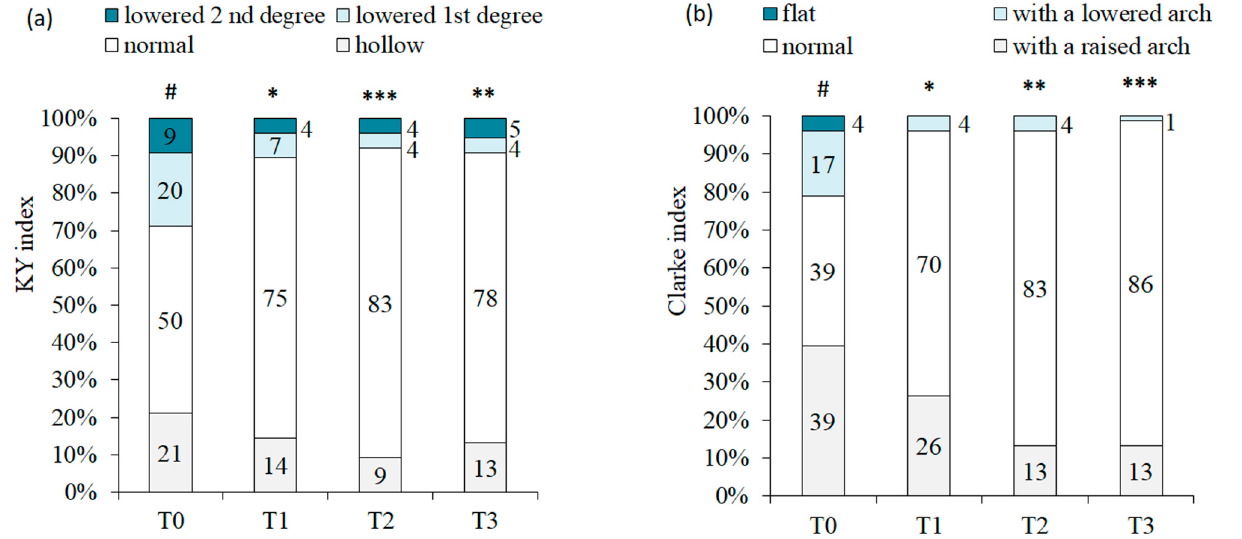
Figure 3. Percentage of feet with different longitudinal arches determined by Sztriter–Godunow index (KY) ( a ) and Clarke index (CL) ( b ) in group T before the treatments (T0), # p before_after < 0.001; and after 1 (T1), 2 (T2), and 3 (T3) treatments; * p < 0.05; ** p < 0.01; *** p < 0.001.